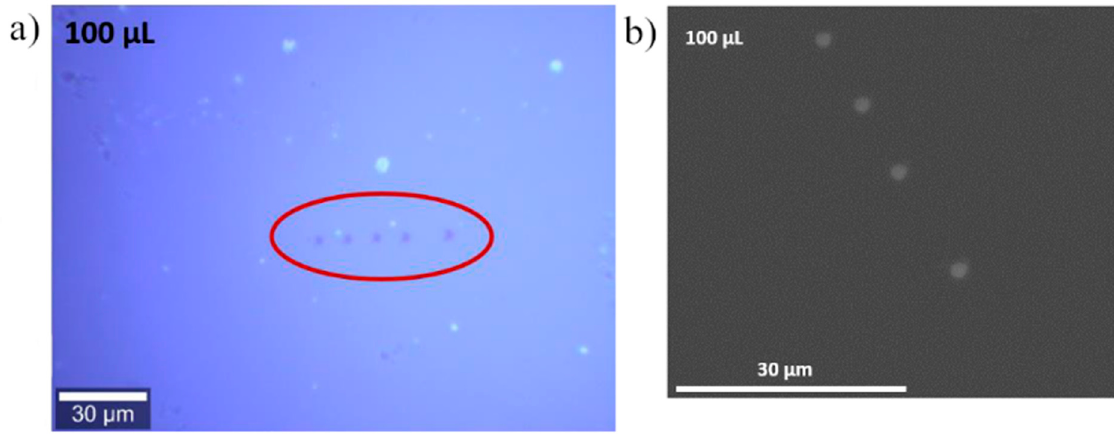
Figure 2. ( a ) Optical microscope image of DAD film spun from a 100 µL volume. The blue areas are the DAD film and the small white dots are air bubble holes in the film. The dark dots in the red ellipse are the burnt holes; ( b ) SEM image of holes in the DAD film spun from a 100 µL volume. In both cases a spin speed of 5000 rpm was used.